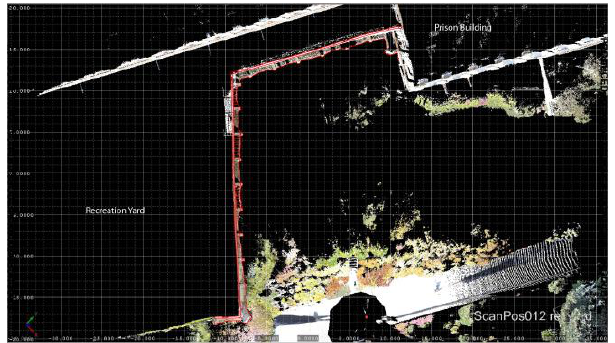
Figure 16. Catwalk scan and